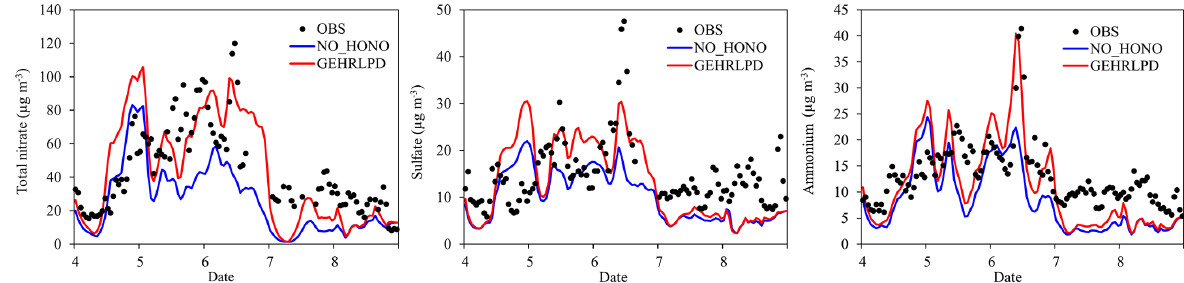
Figure 8. Temporal variation of observed and simulated total nitrate, sulfate, and ammonium concentrations in the NO_HONO and GEHRLPD cases at the Heshan site during 4–8 January 2017.